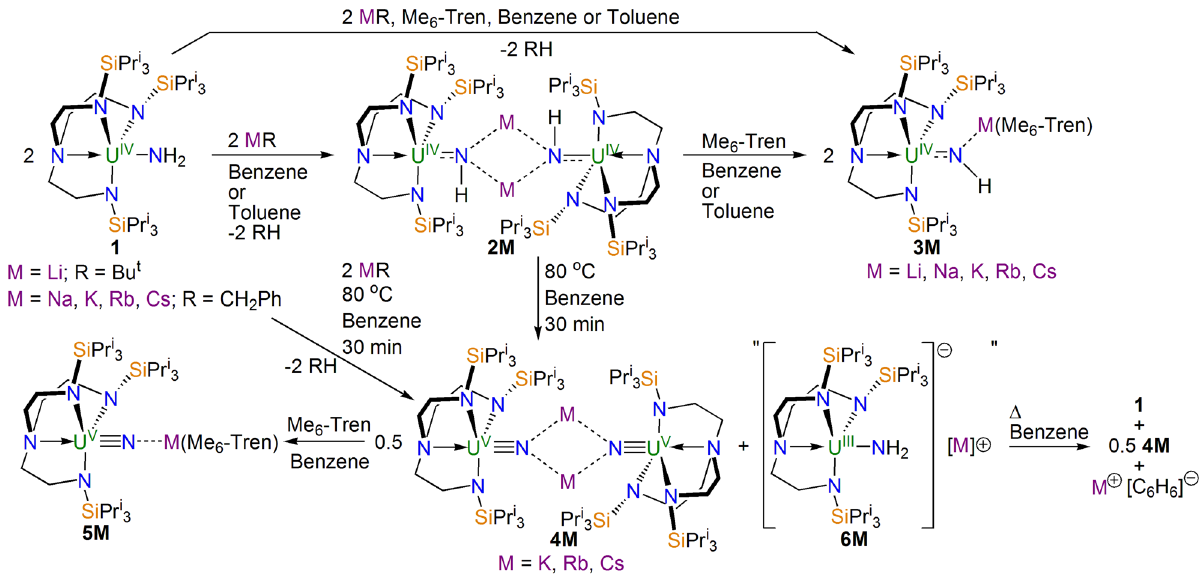
Fig. 1 Synthesis of 2M – 6M. Complex 1 is deprotonated by organo-alkali metal reagents to afford the imido dimers 2M . The imido dimers 2M can be converted to the imido monomers 3M by addition of Me 6 -Tren. Either isolated or in situ prepared 2M when heated in benzene afford the nitride dimers 4M , which can be converted to the nitride monomers 5M by addition of Me 6 -Tren. Complexes 6M were not isolated, but their oxidation product, 1 , was isolated.